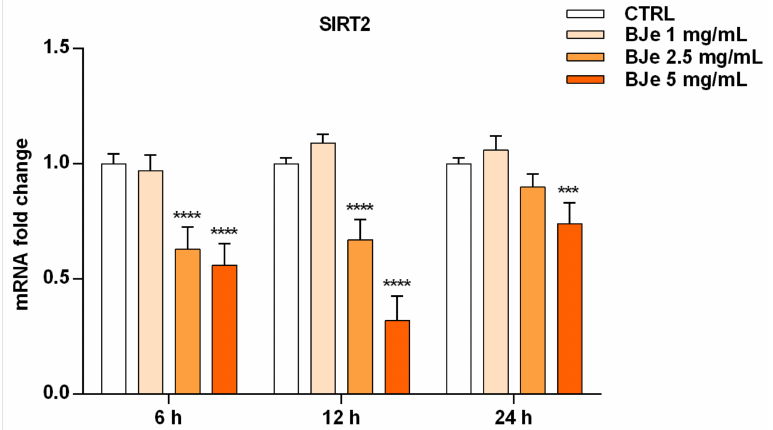
Figure 9. Gene expression of SIRT2 modulated by BJe in treated THP-1 cells. Cells were exposed to different concentrations of BJe (1–5 mg/mL, orange bars) for 6, 12 and 24 h. The mRNA levels were quantified by RT-PCR analysis and calculated by using the 2 – ∆∆ CT method, with β -actin as housekeeping gene. Results are expressed as fold change compared to the untreated cells. Data, represented as mean ± SEM, report the values obtained in three different sets of experiments made in triplicate ( n = 9). *** p < 0.001 and **** p < 0.0001 vs.